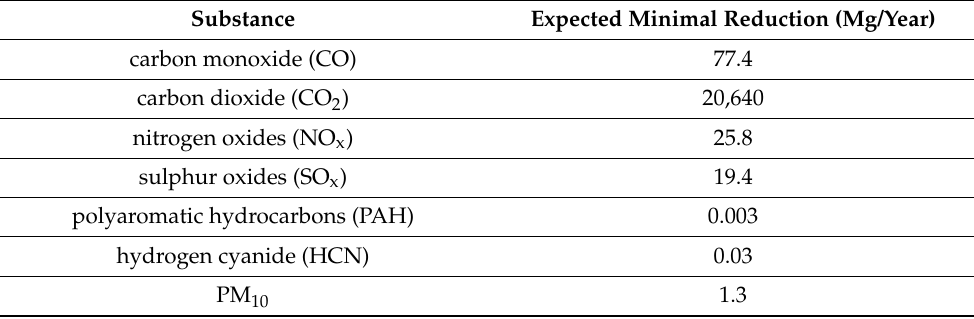
Table 1. Minimal expected emission reduction from coke oven battery heating in Poland resulting from the implementation of a new temperature assessment method in heating